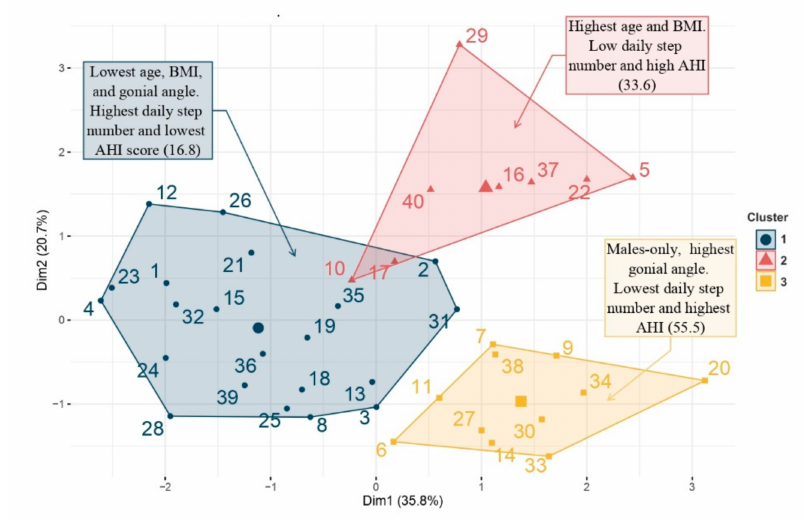
Figure 2. Factor map obtained by agglomerative hierarchical cluster analysis. The 3 clusters are characterized in Table 3.